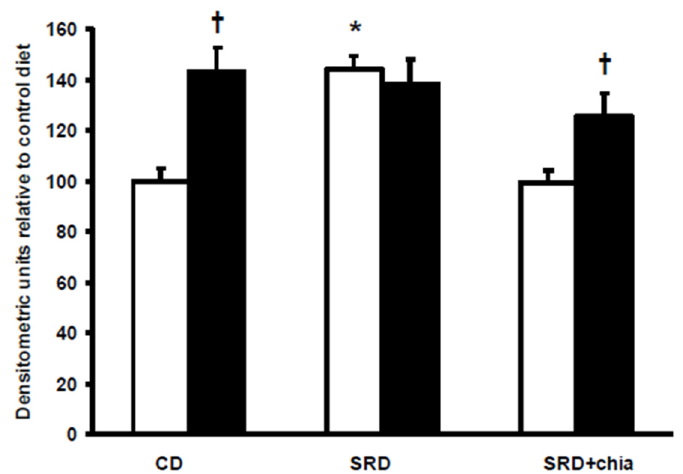
Values are mean, with their standard errors depicted by vertical bars (six animals per group) and expressed as percentage relative to the control diet at 0 min of the clamp. * p < 0.05 SRD at 0 min vs . CD and SRD+chia at 0 min of the clamp. † p < 0.05 CD and SRD+chia at 120 min vs . CD and SRD+chia at 0 min of the clamp. Figure 2. Heart protein mass levels of FAT/CD36 at the beginning (0 min) and under the insulin stimulation at the end (120 min) of the clamp studies in rats fed a control diet (CD), a sucrose-rich diet (SRD) or SRD + chia seed (SRD + chia). Top panel: a representative immunoblot of heart FAT/CD36 of rats fed CD, SRD and SRD + chia. Molecular marker is shown on the right. Lane 1, CD 0 min; lane 2, CD 120 min; lane 3, SRD 0 min; lane 4, SRD 120 min; lane 5, SRD + chia 0 min; lane 6, SRD + chia 120 min. Bottom panel: densitometric immunoblot analysis of heart FAT/CD36 protein mass level of rats fed CD, SRD or SRD + chia at the beginning (0 min □ ) and at the end (120 min ■ ) of clamp studies.